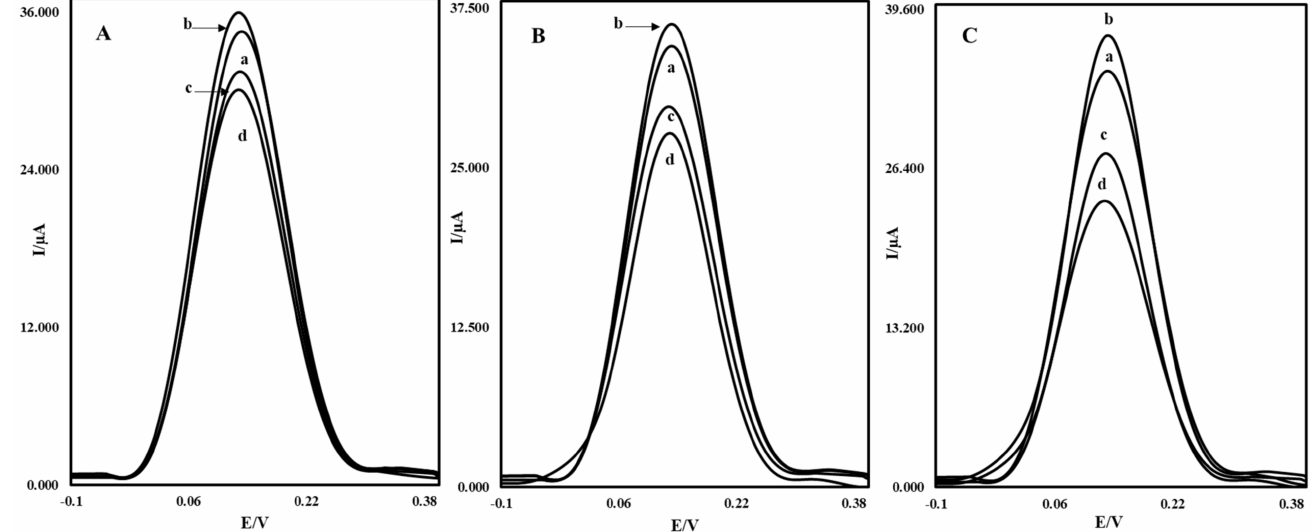
Figure 3. DPV diagrams of the electrodes modified with nanocomposite ( A ) MWCNTs-AuNPs, ( B ) MWCNTs-AuNPs/CS-AuNPs, and ( C ) MWCNTs-AuNPs/CS-AuNPs/rGO-AuNPs in a solution containing K 3 Fe (CN) 6 and K 4 Fe (CN) 6 3.0 mM and 0.1 M KCl. (a) relating to the unmodified electrodes, (b) modified electrodes with the synthesized nanocomposites, (c) modified electrodes after aptamer addition and (d) modified electrodes with aptamer after 30 min interaction with OTC 10.0